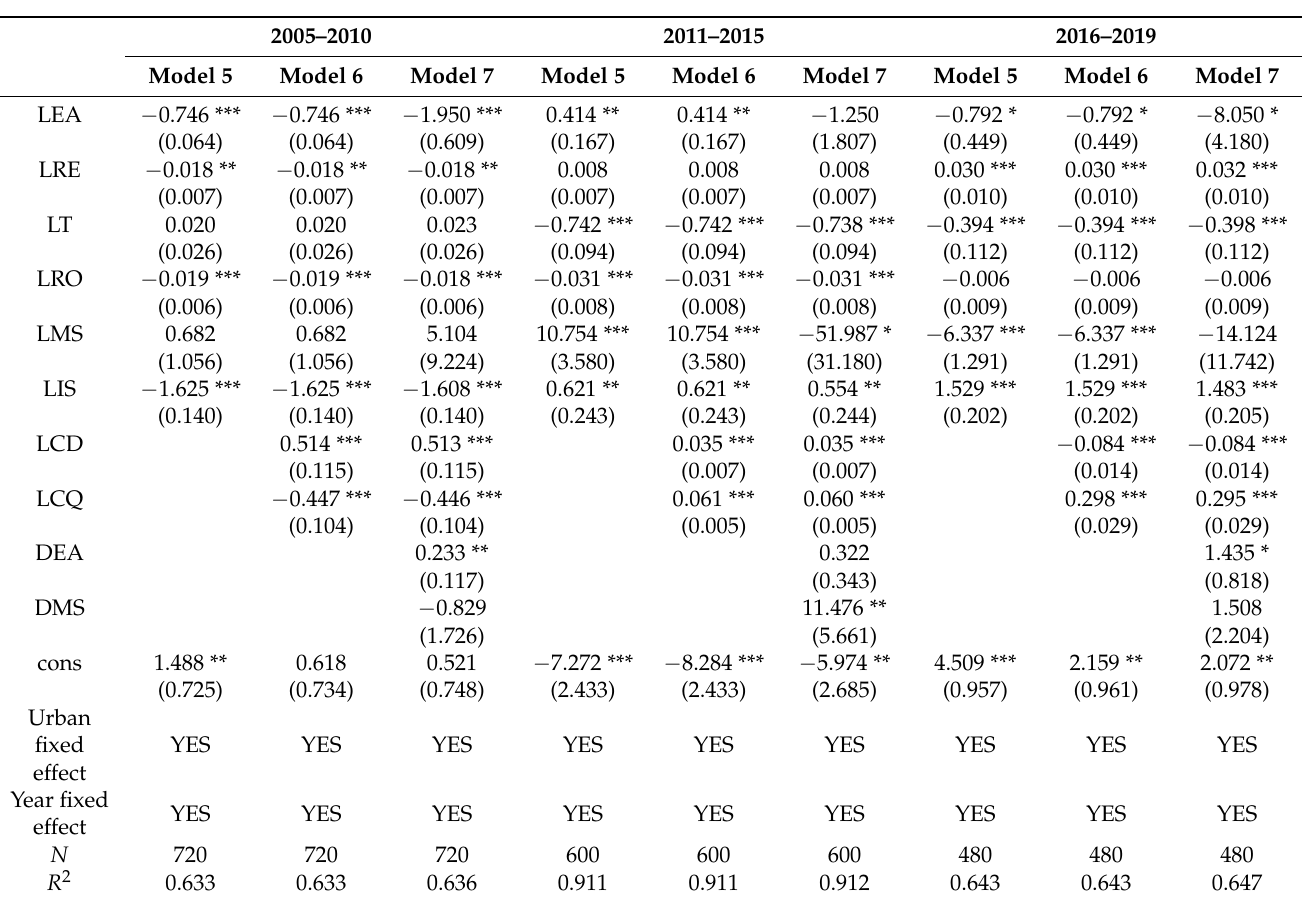
Table 4. Fixed effect of